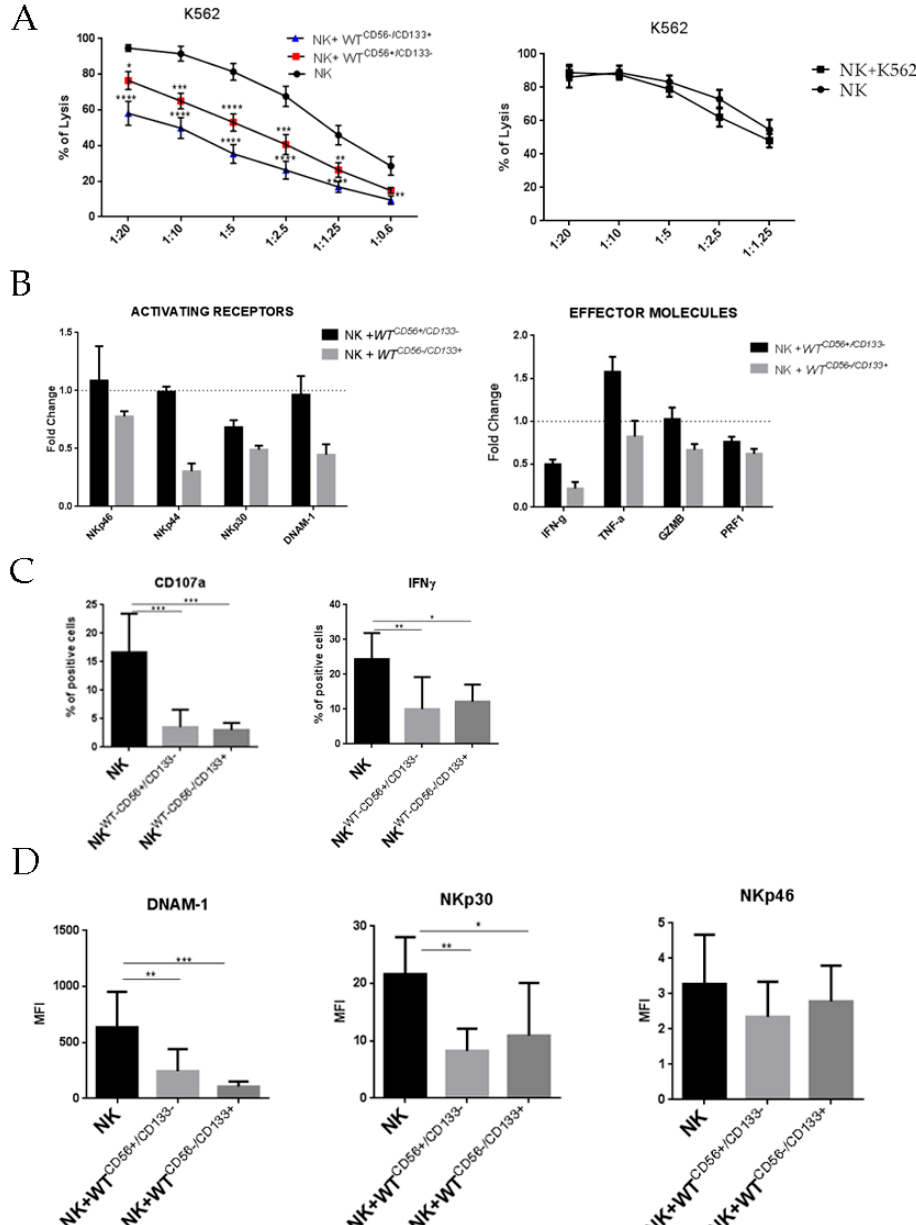
Figure 3. Evaluation of IL2 activated NK cell cytotoxic activity before and after co-culture with WT primary cultures ( A ) The cytotoxicity assay of NK cells from healthy donors cultured alone or with WT cell lines in the presence of IL2 on the left and alone or with K562 cells in presence of IL2 on the right. After six days, NK cells were incubated with K562 target cells for 4 h at the indicated E:T ratio. Data shown here are the average of four independent experiments for each WT cell line ± SEM. Statistical significance was determined by Student’s t -test (* p < 0.05, ** p < 0.01; *** p < 0.001; **** p < 0.0001). ( B ) mRNA fold change of activating receptors (NKp46, NKp44, NKp30, and DNAM-1) and effector molecules (IFN γ , TNF α , Granzyme B, and Perforine1). The results are the means ± SEM of three different experiments with different NK donors. ( C ) NK cell surface expression of CD107a and intracellular expression of IFN- γ after six days of culture alone or with WT cell lines under direct contact. The results are the mean ± SEM of three different experiments for each WT cell line. p -values were calculated using one-way ANOVA with Fisher’s LSD multiple comparisons test (* p < 0.05, ** p < 0.01, *** p < 0.001). ( D ) Surface expression of DNAM-1, NKp30 and NKp46 were measured by flow cytometry in NK cells on day six of culture with IL-2 alone or in presence of WT cells. Bar graphs show the mean fluorescence intensity (MFI) ratio between stained and unstained cells. The results are the means ± SEM of three different experiments for each WT cell line. p -values were calculated using one-way ANOVA with Fisher’s LSD multiple comparisons test (* p < 0.05, ** p < 0.01, *** p <